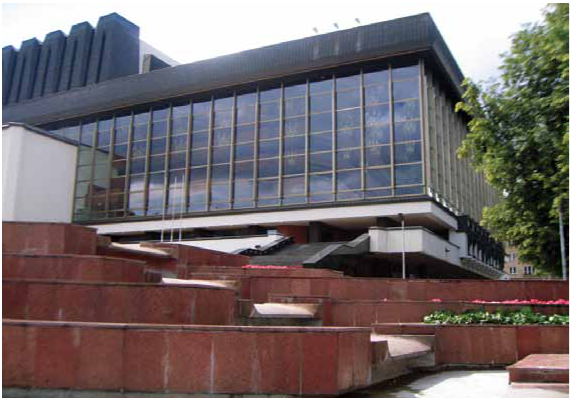
Fig 5. View of the opera and Ballet Theater. a. novickas